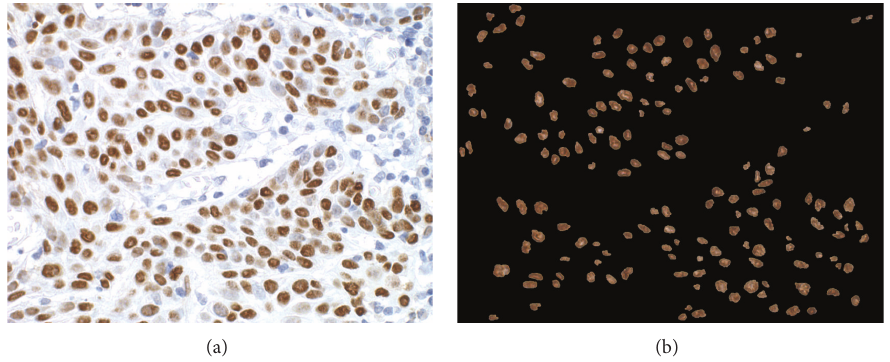
Figure 1: (a) Digitized frame from P63 stained specimen and (b) P63 expressed nuclei.